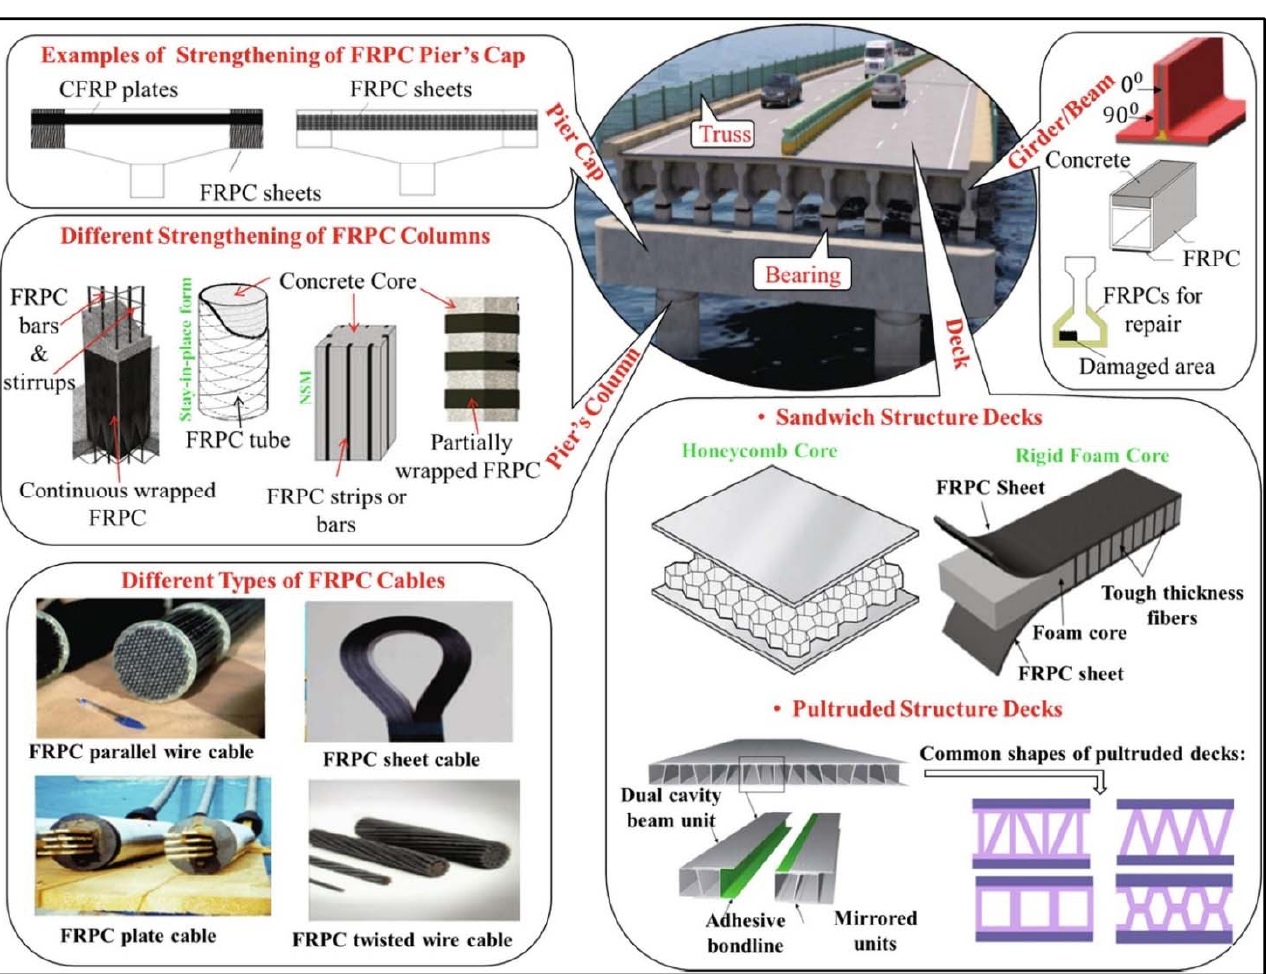
Figure 7. FRP utilization in bridge construction [27] (reprinted with kind permission from Elsevier).